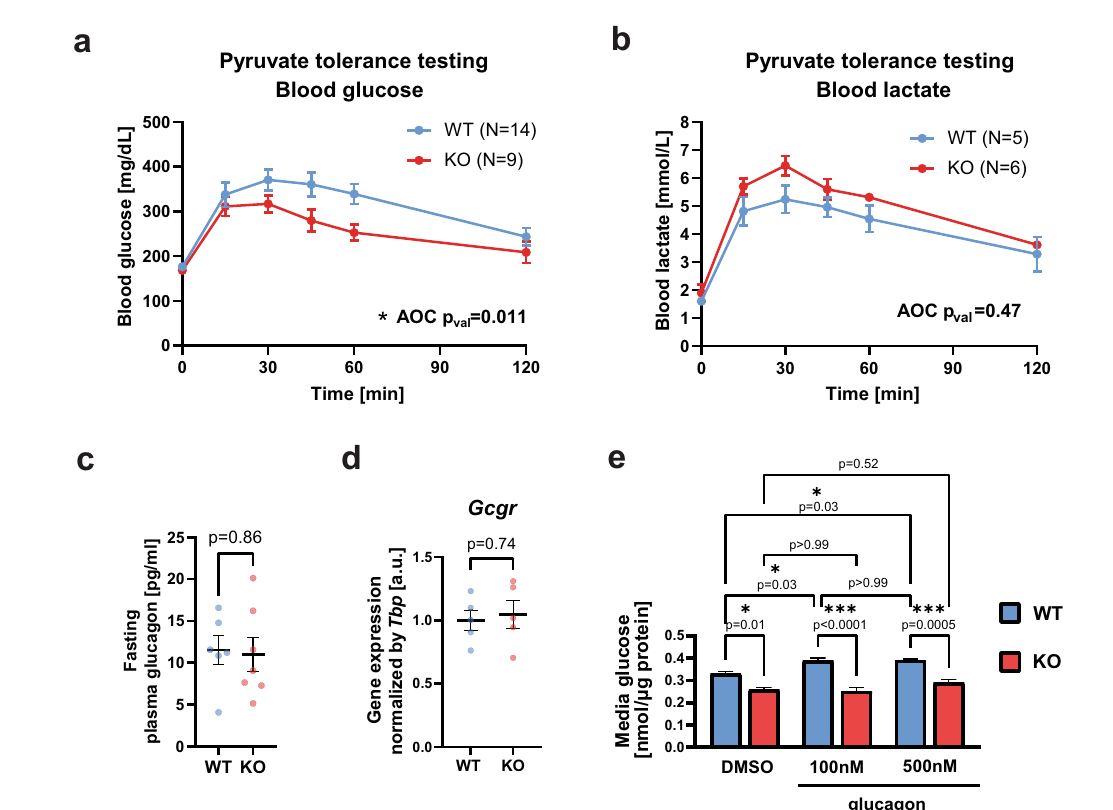
Fig. 3 | GPR151 upregulates the expression of hepatic gluconeogenesis genes. a RT-qPCR quanti fi cation of Gpr151 gene expression in the livers of Gpr151 WT and KOmice( N =5,WT; N =5,KO).Dataarepresentedasmeanvalues±SEM. b Principal component analysis showing the clustering of samples analyzed by RNA-Seq. c Volcano plotshowingthe statisticalsigni fi cance( − log10(p adj ))versuslog2of fold change of gene expression between Gpr151 KO and WT livers. d Heat map of transcriptional regulation patterns between DE genes ( p -val adj <0.05) from the